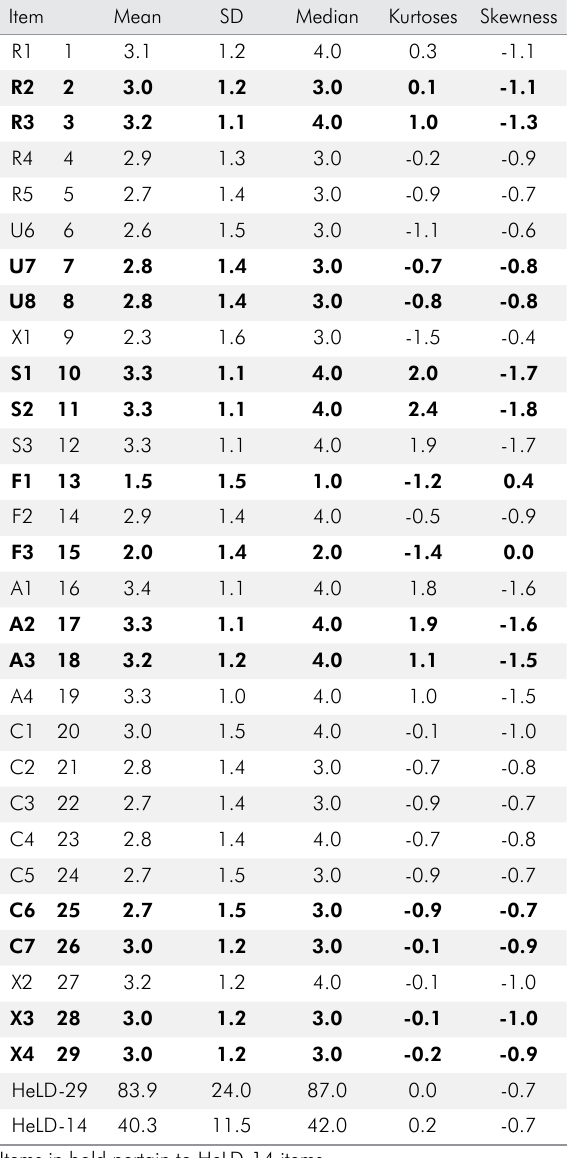
Table 1. Summary measures of each item of the Health Literacy in Dentistry scale (HeLD-29 and HeLD-14).